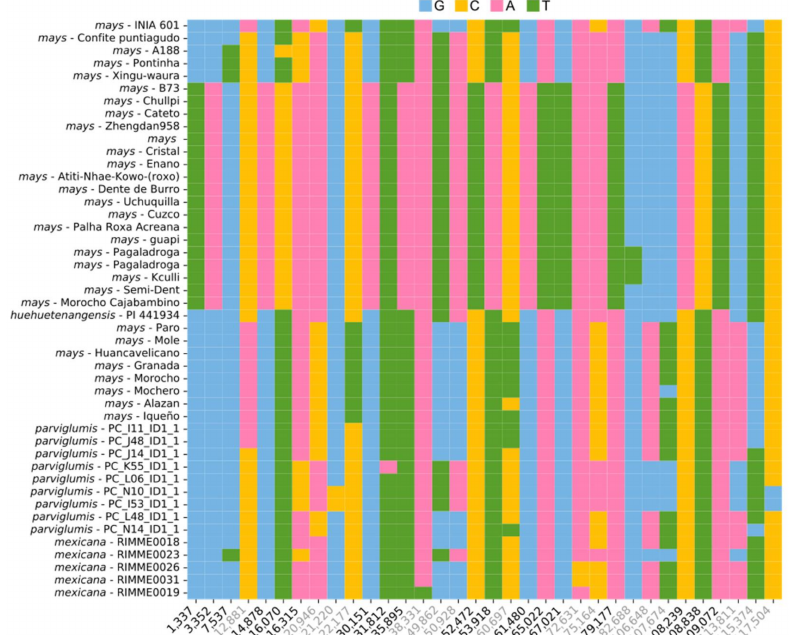
Figure 2. Plot showing the alignment position and identity of plastid SNVs. The 18 high-confidence positions are shown in black, and the other positions are shown in grey. Colors indicate the allele: G—blue, C—yellow, A—pink,